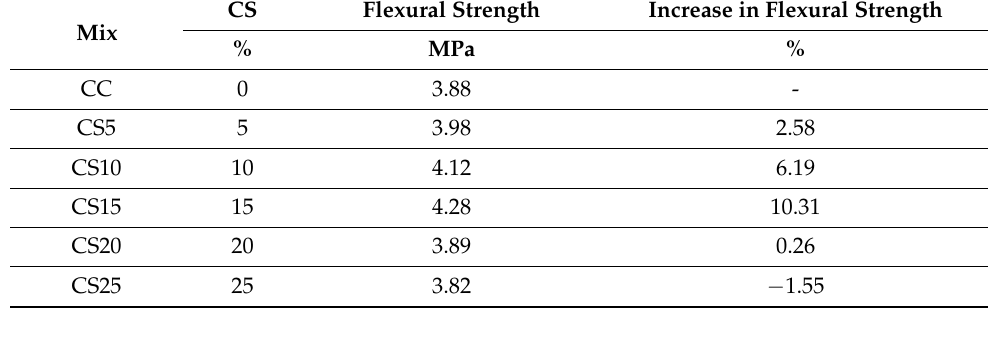
Table 5. Flexural strength of CS concrete. Figure 5. Split tensile strength of CS concrete.